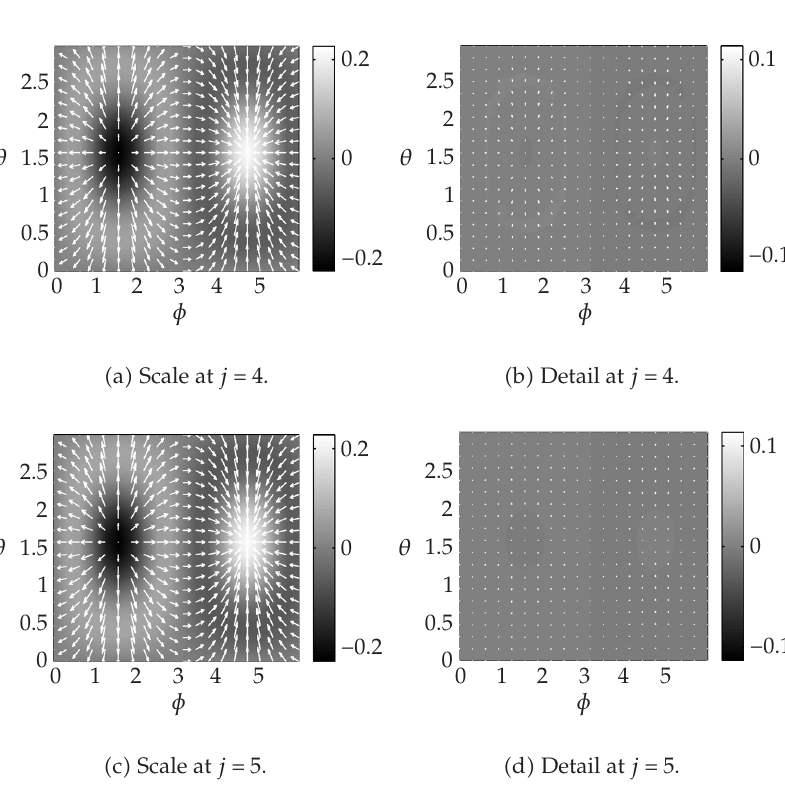
Figure 6.6 . Scale ( left ) and detail ( right ) reconstructions at levels 4 and